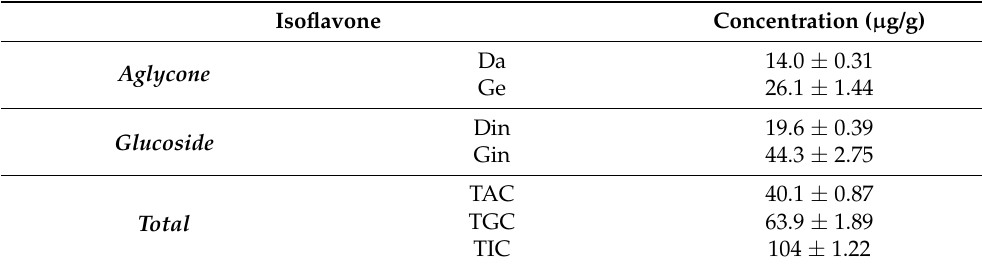
Table 2. Isoflavone content of control soymilk (CSM) obtained from conventional extraction